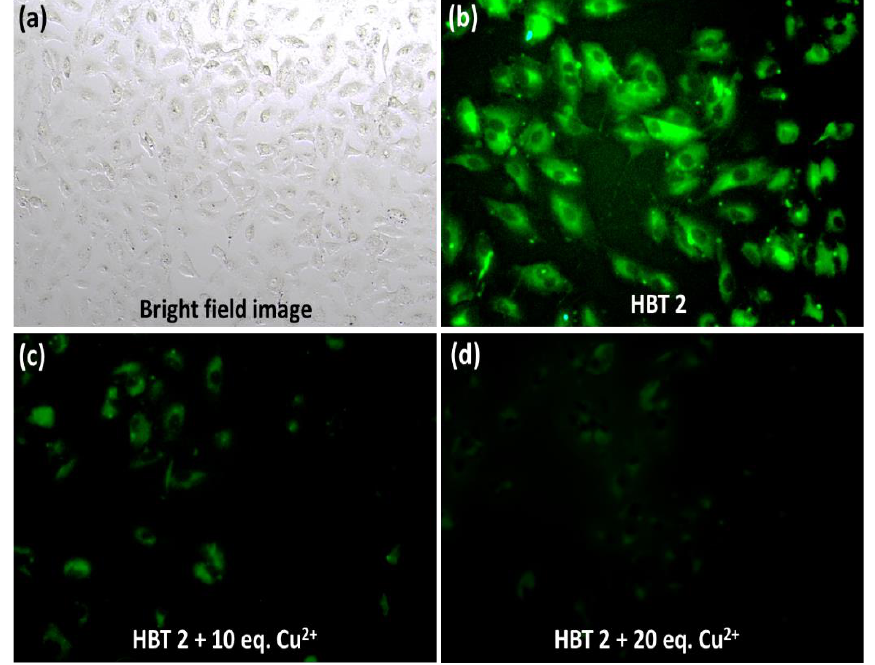
Figure 9. ( a ) Bright field image; ( b ) Fluorescence image (at 10×) of A549 lung cancer cells incubated with HBT 2 (1 μM); Fluorescence image of A549 cells incubated with HBT 2 followed by incubation with ( c ) 10 equivalents and ( d ) 20 equivalents of Cu 2+ ions.